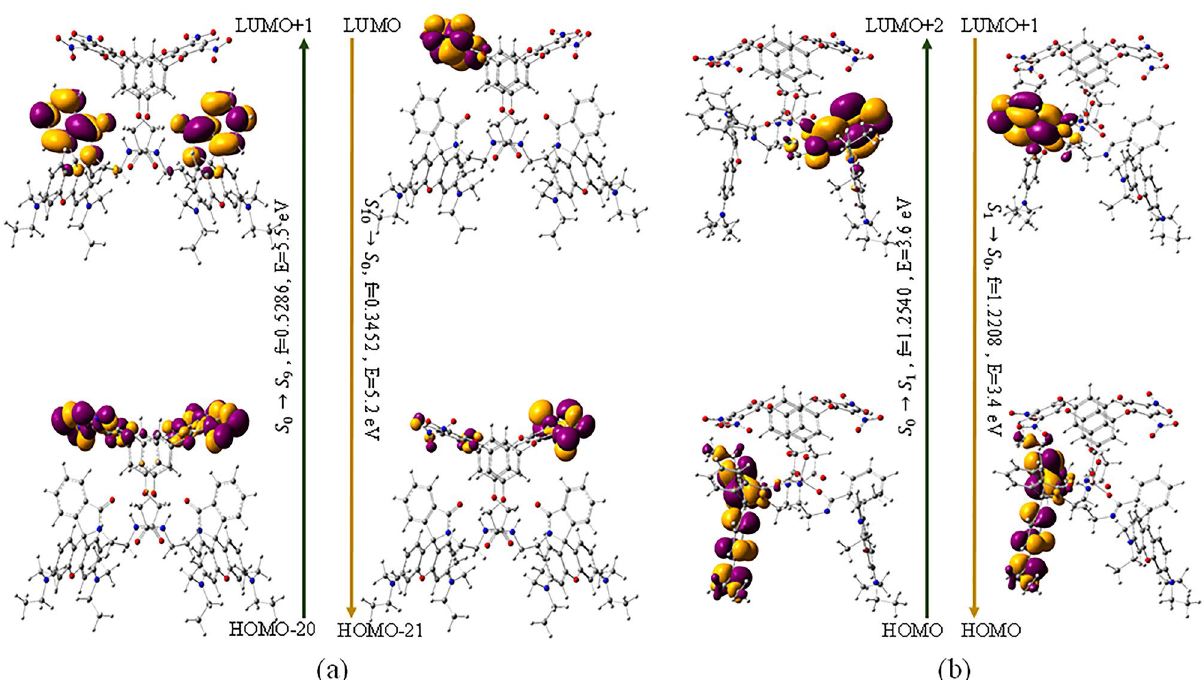
Figure 8. Electron density maps of the Frontier Molecular Orbitals (FMO) of L-Al 3+ complex representing the electronic transitions of absorption and emission band on the optimized geometries of ( a ) L and ( b ) L-Al 3+ at